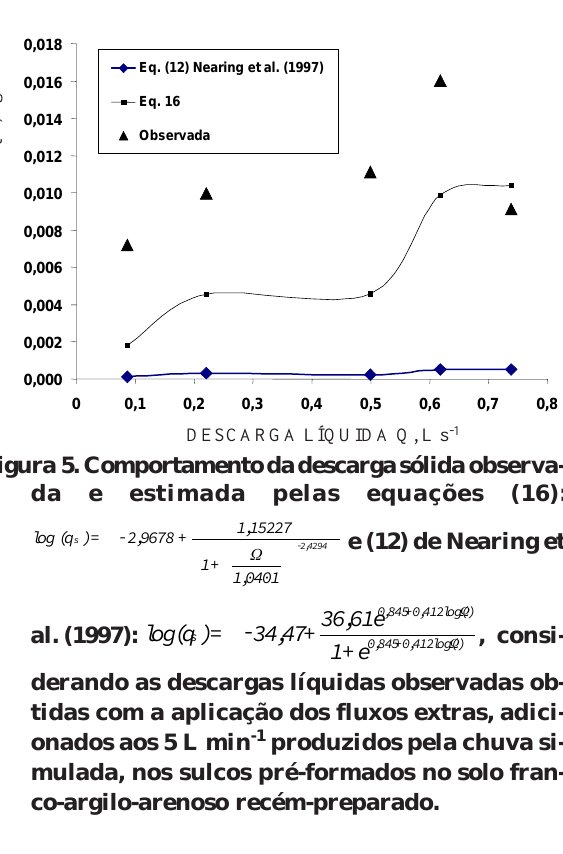
Figura 4. Representação da descarga sólida estimada pela potência do escoamento ( ΩΩΩΩΩ = ρρρρρ kg S -3 ), para os fluxos extras aplicados de 0, 10, 20, 40 e 50 L min -1 , adicionados aos 5 L min -1 produzidos pela chuva simulada, nos sulcos pré-formados no solo franco-argilo-arenoso recém-preparado.